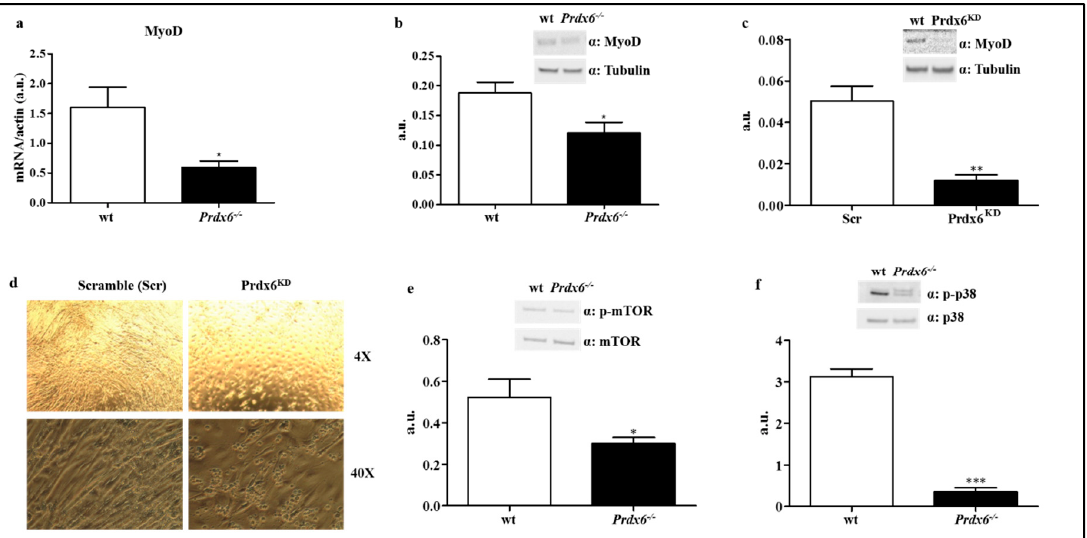
Figure 5. Suppression of Prdx6-reduced MyoD-mediated muscle differentiation. ( a ) MyoD gene expression was evaluated in gastrocnemius of wt (white bar) and Prdx6 -/- (black bar) mice. ( b,c ) MyoD gene and protein levels were tested in murine myoblasts cells (C2C12) stably silenced for Prdx6 (Prdx6 KD ) (white bar) and in control cells (Scramble, Scr) (black bar). ( d ) Murine myoblasts cells differentiation at both 4× and 40× of magnification. ( e ) Protein phosphorylation levels of mTOR (p-mTOR) in gastrocnemius of Prdx6 -/- and wt mice were analyzed. ( f ) Phosphorylation levels of p38 (p-p38) were measured in muscle of Prdx6 -/- and wt mice. Results are expressed as mean ± SE. * p < 0.05, ** p < 0.005; *** p < 0.0005 using Student t test. Graphs illustrate one of three separate studies, all yielding similar results ( n = 5 mice per group). a.u. = arbitrary units.